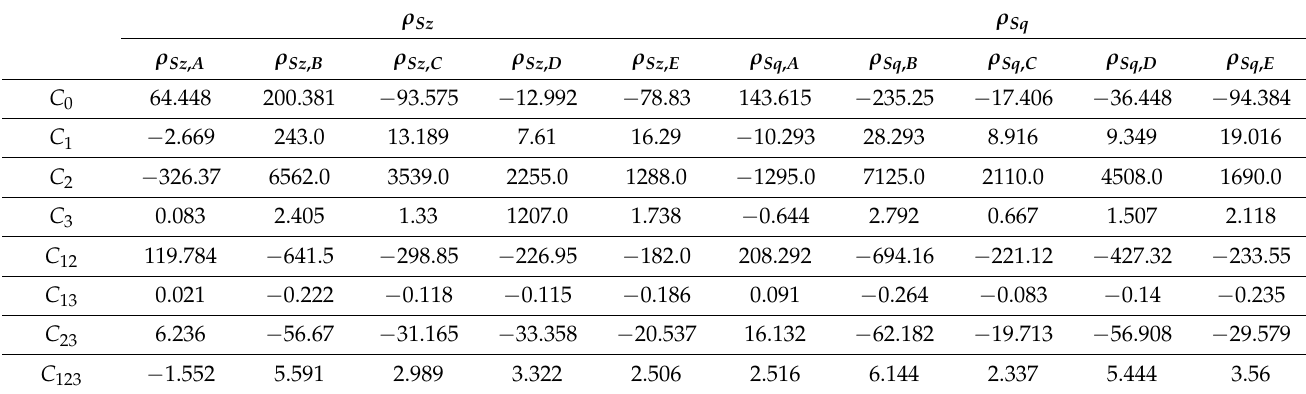
Table 11. The constants for regression improvement equations for S z and S q